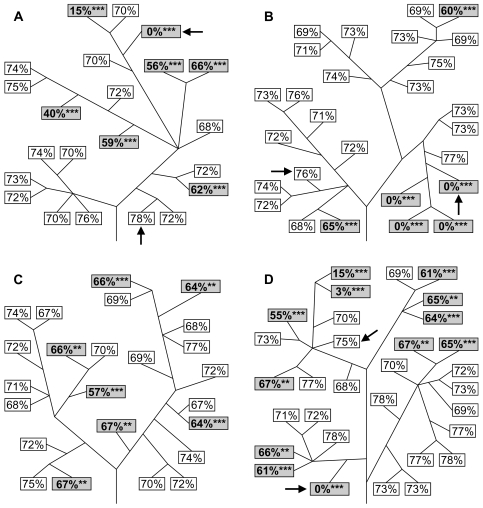
Instability of kanamycin resistance.The percentages of kanamycin resistant progeny from a number of self-fertilised seed capsules are shown for kr2.3 (A), kr2.5 (B), kr2.7 (C) and kr2.10 (D). Each box represents a seed capsule, with the percentage of kanamycin resistant progeny from that capsule shown. Approximately 200–250 seeds from each capsule were tested for kanamycin resistance. Lines represent branches (not to scale) and are included to show the branching pattern of the plants from which individual seed capsules were progeny tested. Seed capsules that deviate significantly (P<0.01) from the expected 75% kanamycin resistant progeny are highlighted with grey shading. Arrows indicate seed capsules which were used for PCR and DNA blot analysis (see Figures 3 and 4). ** P<0.01, *** P<0.001.